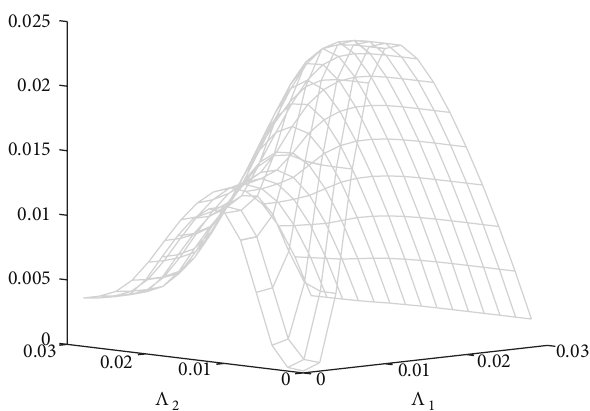
Figure 7: We illustrate here the dependence of 𝑃 Λ (𝜆 0 , 𝑋 0 ) as a function of the exercise boundary Λ ; this allows to find the optimal ( Λ ∗ 1 = 121 bps, Λ ∗ 2 = 0 ) that maximizes the option price.